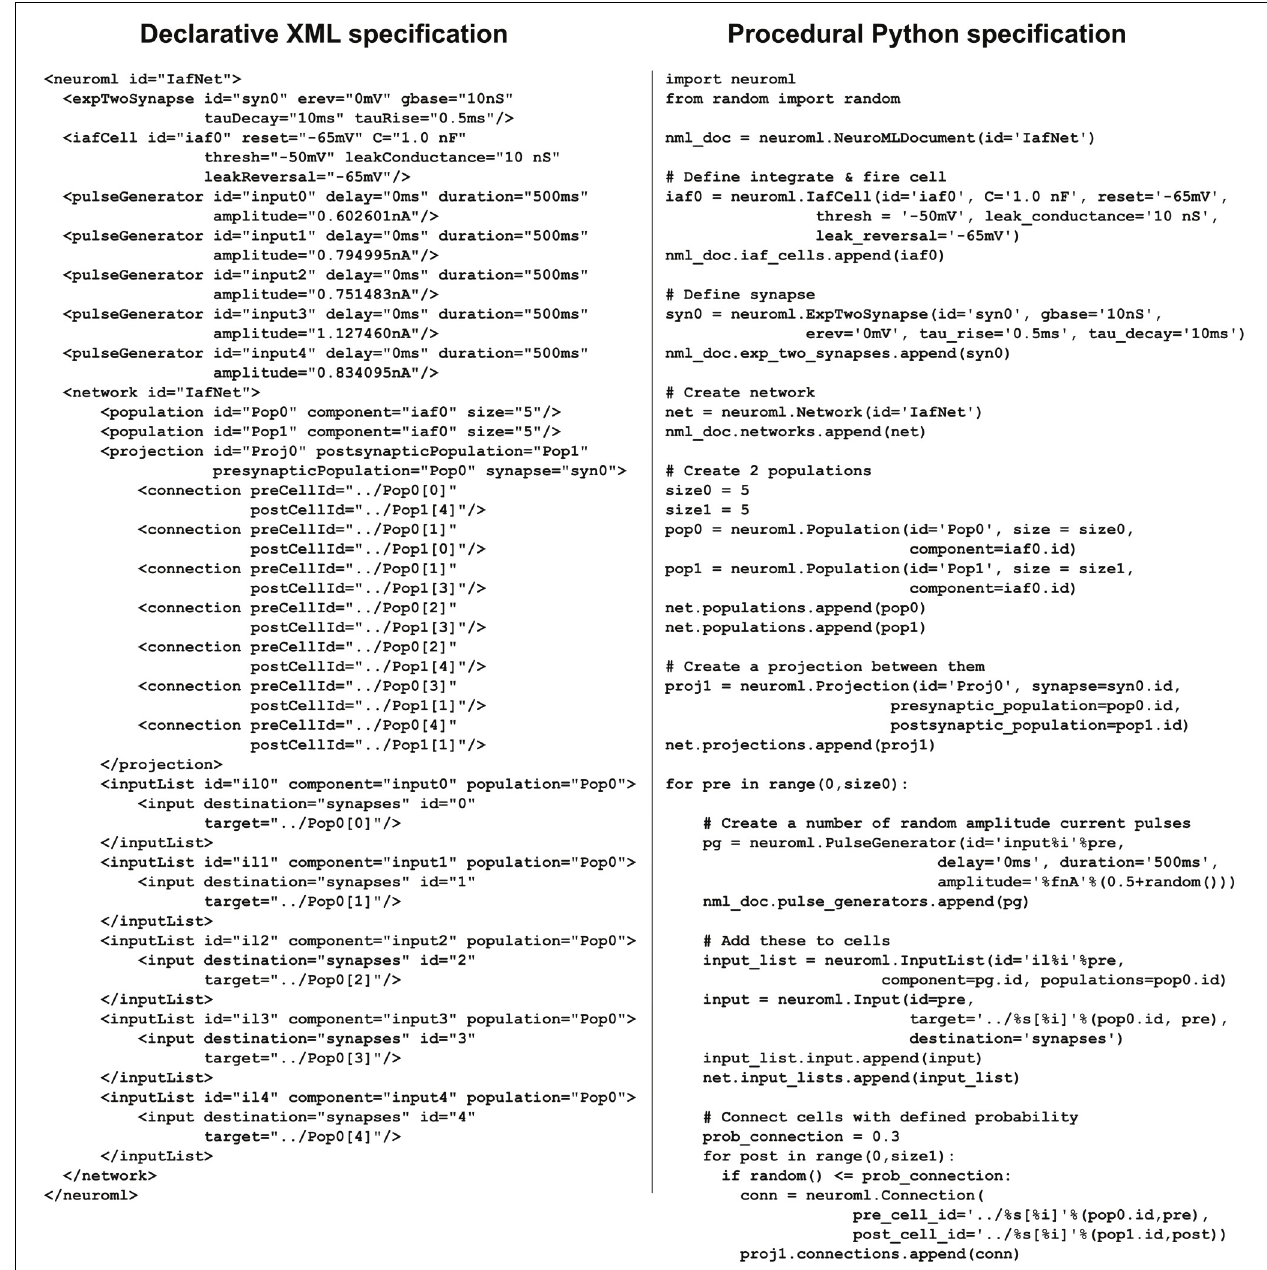
FIGURE 7 | Example of creation of a network of integrate-and-fire neurons using libNeuroML (right) and the equivalent XML representation (left). The network consists of two populations of five cells each. The cell type is a simple integrate-and-fire cell using the NeuroML element iafCell . A prototype component is created for this setting all of the